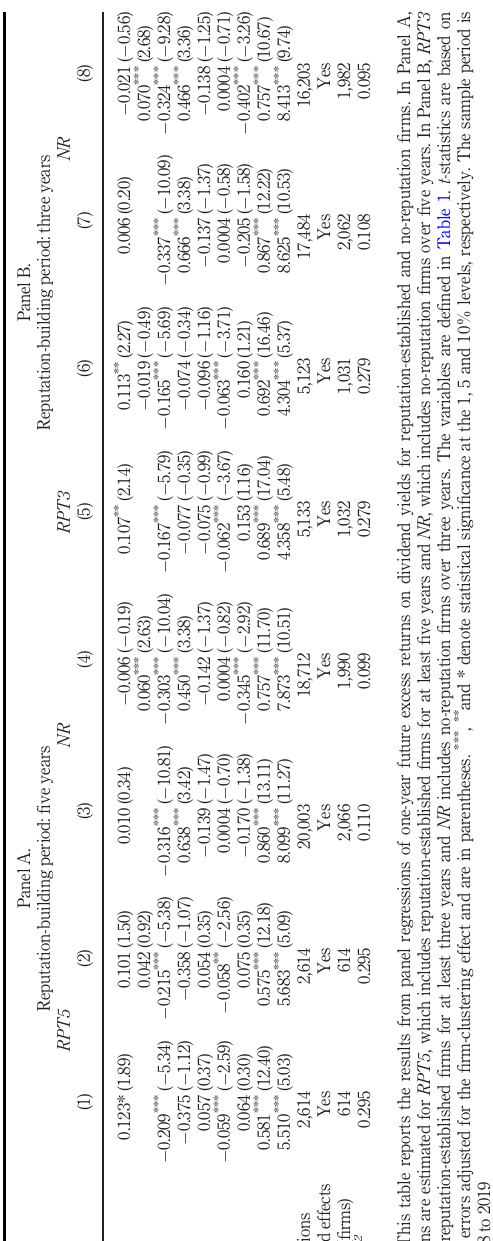
Table 9. Relation between stock returns and dividend yields for reputation and no reputation groups: panel